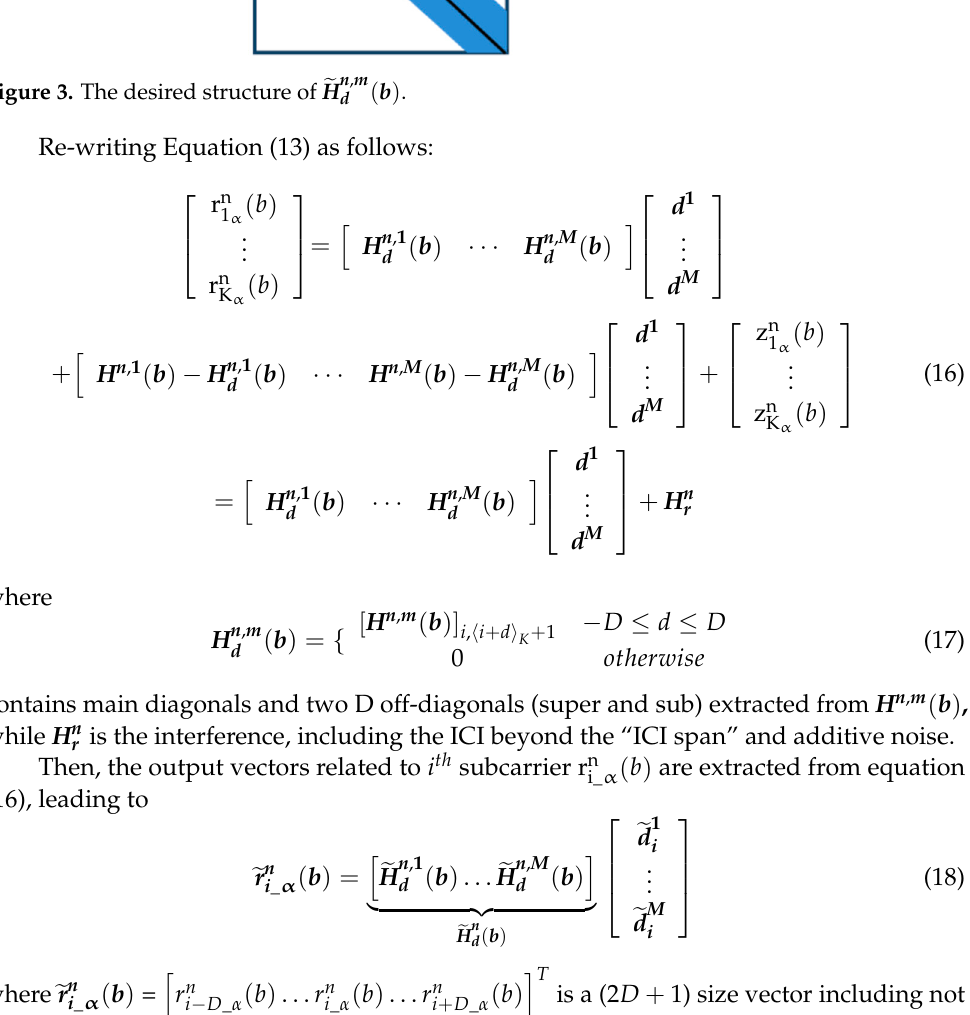
𝒏,𝒎 (cid:4666)𝒃(cid:4667) . n , m ( b ) . 𝒅 d